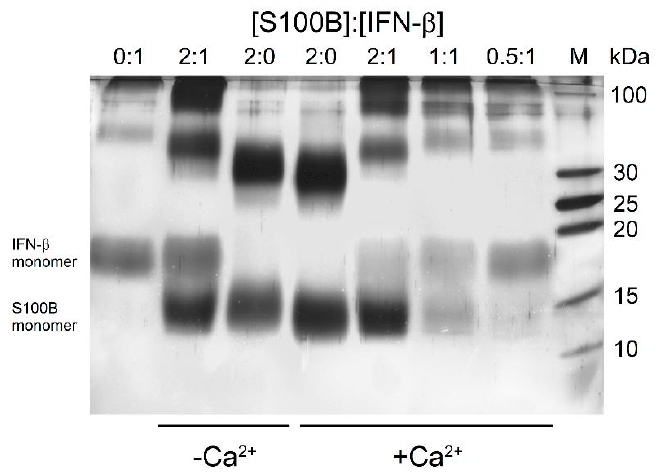
Figure 2. SDS- PAGE results for 5 µM IFN - β with/without Ca 2+ -depleted/bound S100B (S100B to IFN- Figure 2. SDS-PAGE results for 5 µ M IFN- β with/without Ca 2+ -depleted/bound S100B (S100B β molar ratios are indicated) cross -linked with EDAC/sulfo-NHS at 25 °C.